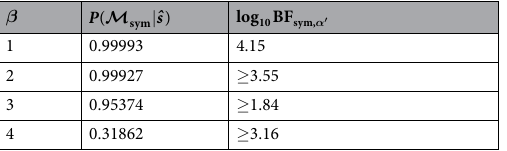
calculated for a dataset of 4 × 10 9 sym